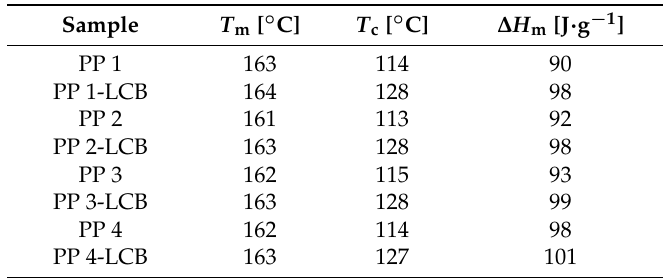
Table 3. Thermal properties of the studied polymer samples.